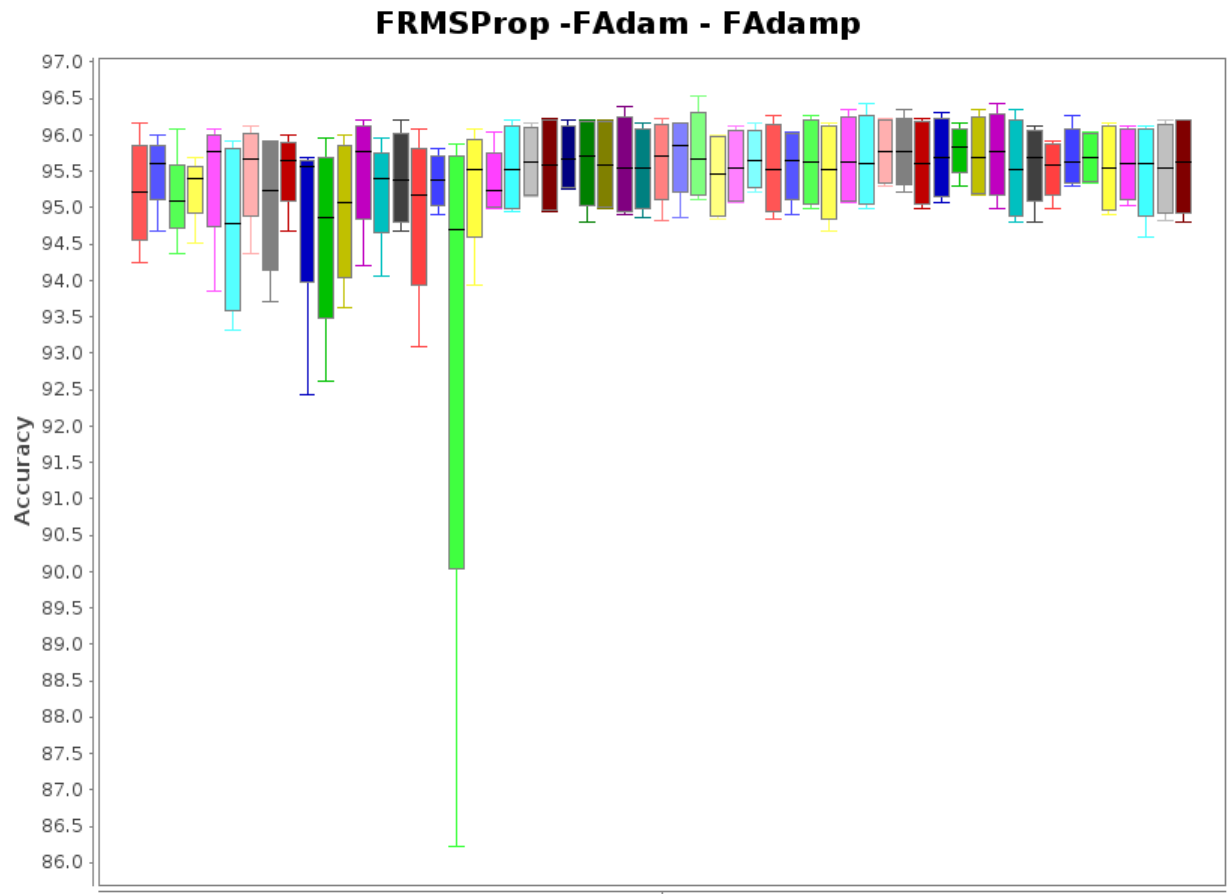
Figure 19. Experiment 3.2: Group 2, cross-folding accuracies, K = 4 folds, ν ∈ [ 0.1,1.9 ]